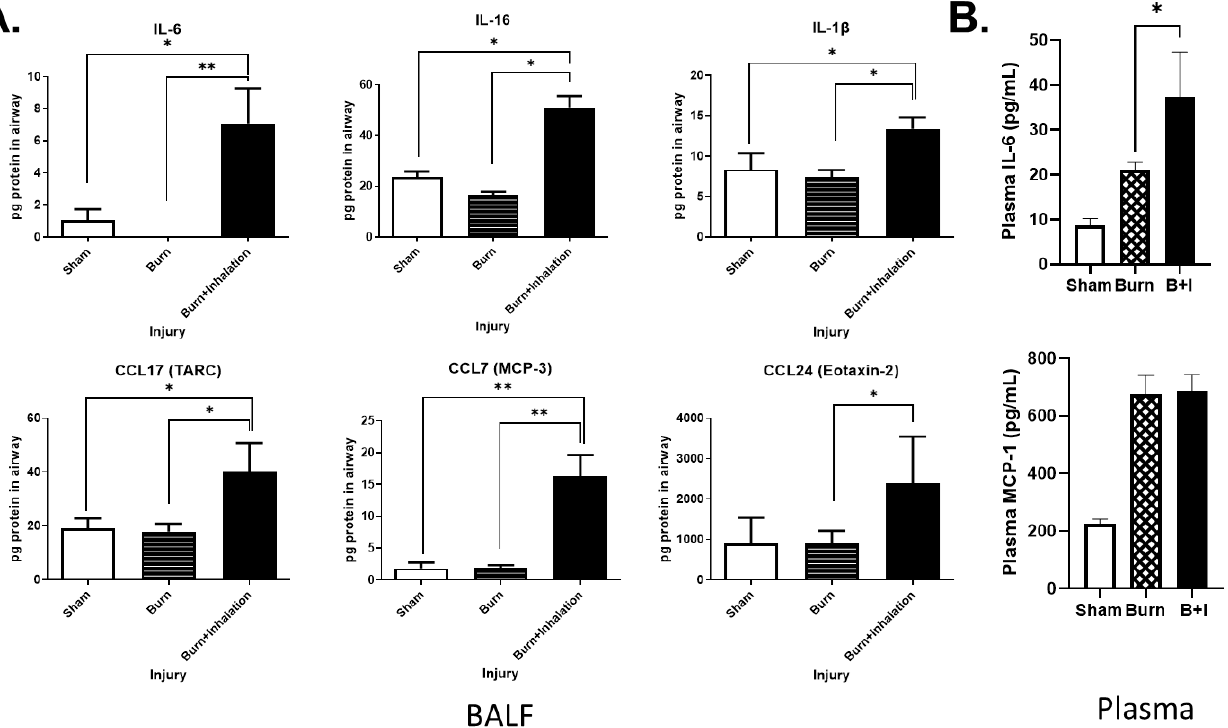
Figure 3. B+I injury significantly alters BALF and plasma cytokines and chemokines compared to burn injury or sham injury alone. Mice underwent sham, burn, or combined injury, and were sacrificed at 24 h post-injury (n = 6 per group). ( A ) Supernatant collected from BALF washes was analyzed using a Bio-Plex mouse cytokine and chemokine 33-plex panel. ( B ) Plasma was analyzed using a Bio-Plex mouse cytokine 8-plex panel. Data shown are +/ − SEM; * p < 0.05, ** p < 0.01.